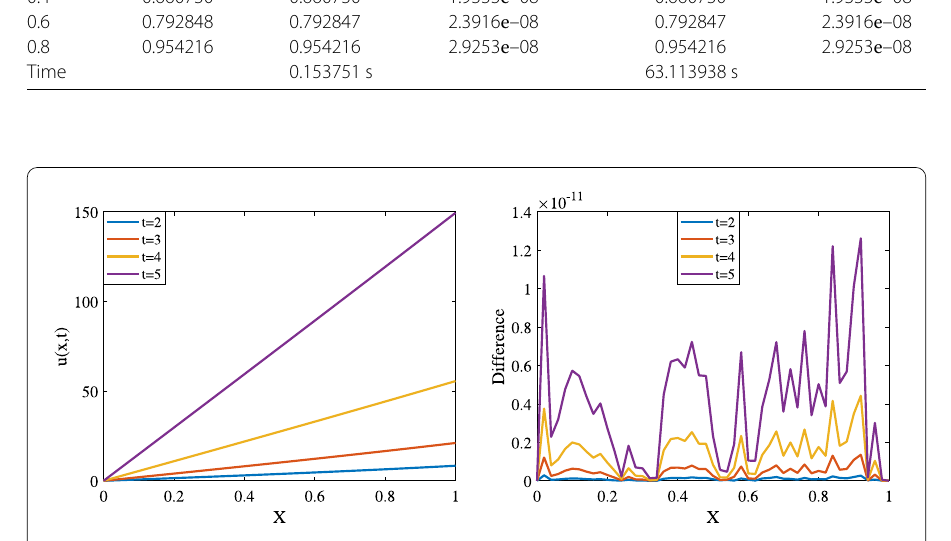
Figure 6 The figures of solutions of R-CFDS4(left) and difference(right) between R-CFDS4 and CFDS4 with h = 0.02 and τ = 0.01 for SP 2